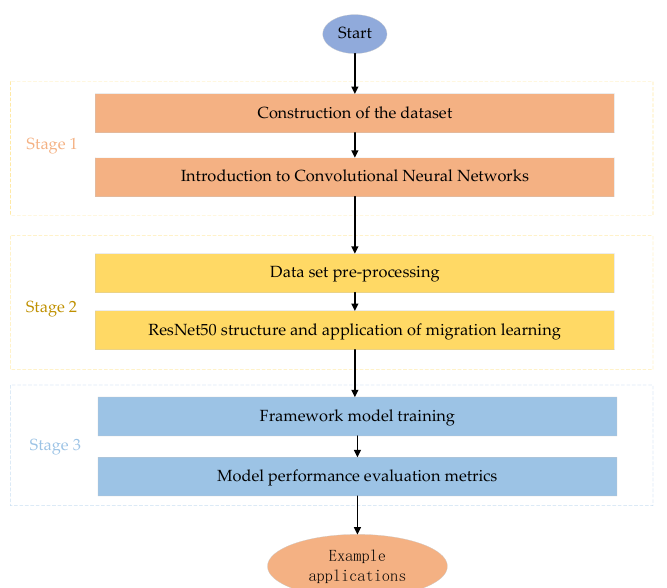
Figure 1. Transfer learning-based process for identifying unsafe driver